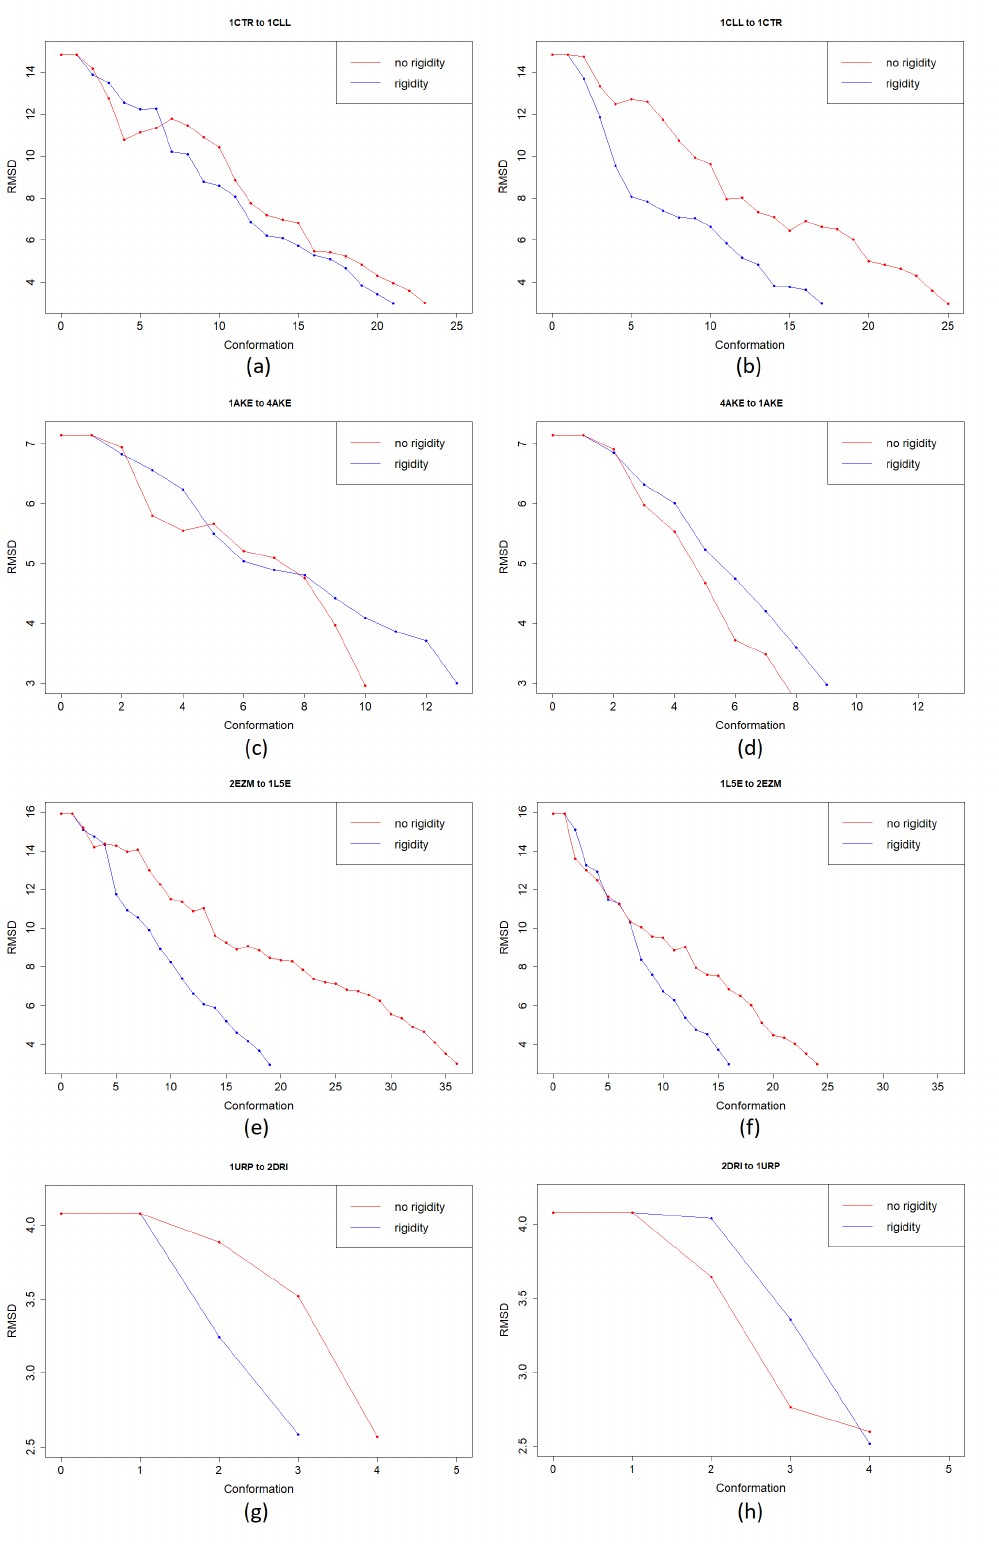
Figure 5. Evolution of lRMSD towards the goal for CaM and AdK. ( a ) 1 CTR → 1 CLL , ( b ) 1 CLL → 1 CTR , ( c ) 1 AKE → 4 AKE , ( d ) 4 AKE → 1 AKE , ( e ) 2 EZM → 1 L 5 E , ( f ) 1 L 5 E → 2 EZM , ( g ) 1 URP → 2 DRI , and ( h ) 2 DRI → 1 URP . The blue line shows the paths obtained by our updated algorithm using rigidity analysis and the red line shows the paths obtained by our previous work based on RRT*